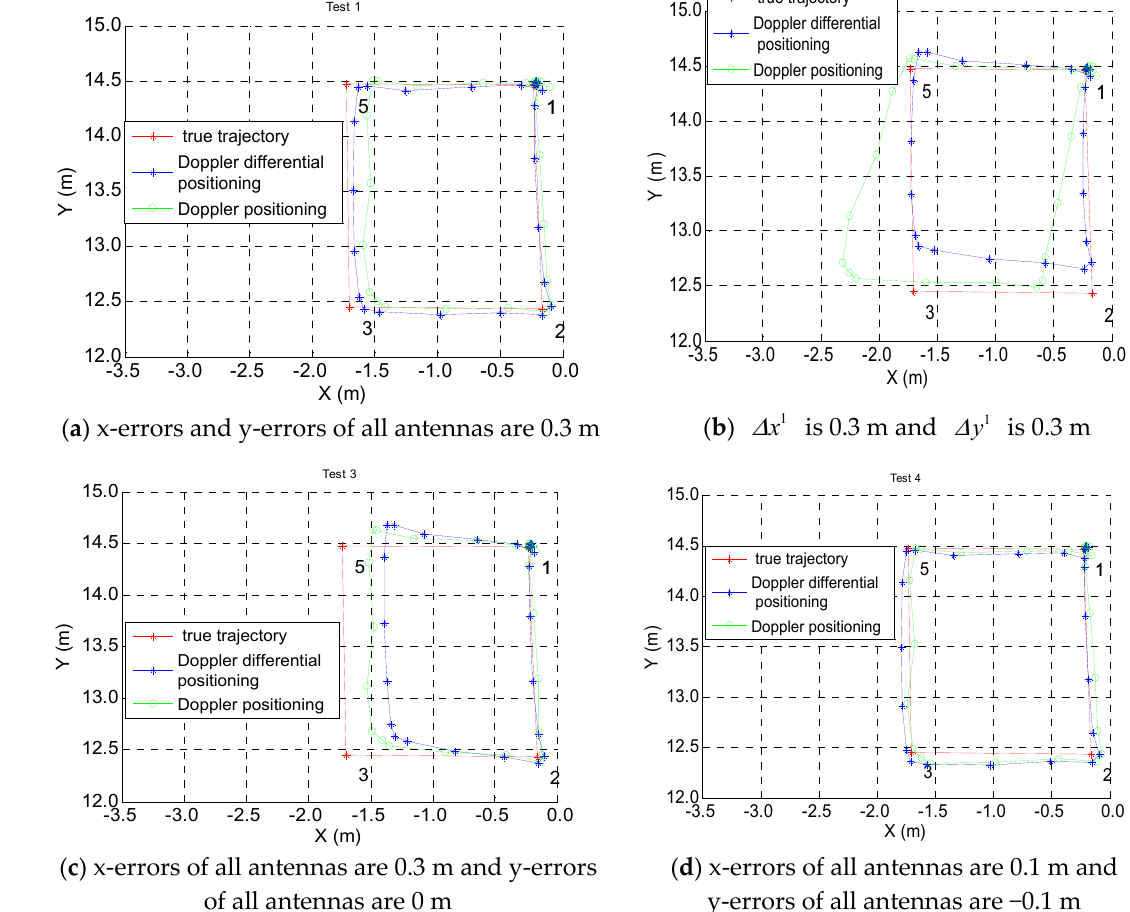
Figure 10. Positioning results with errors of the transmitting antenna coordinates.